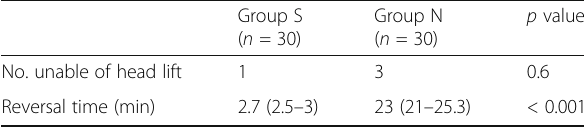
Table 3 Number of patients incapable of head lifting and reversal time